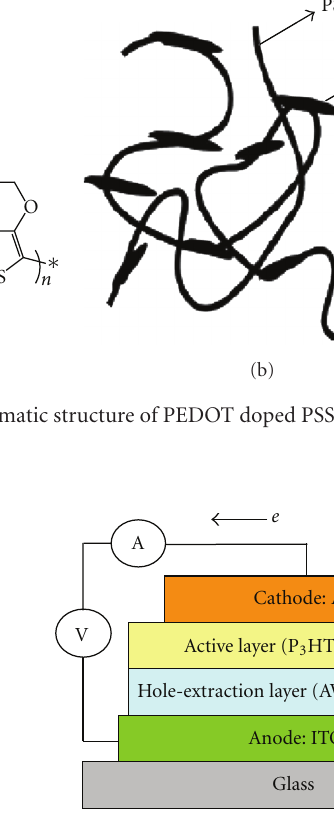
Figure 2: Schematic device structure for organic solar cells doped with